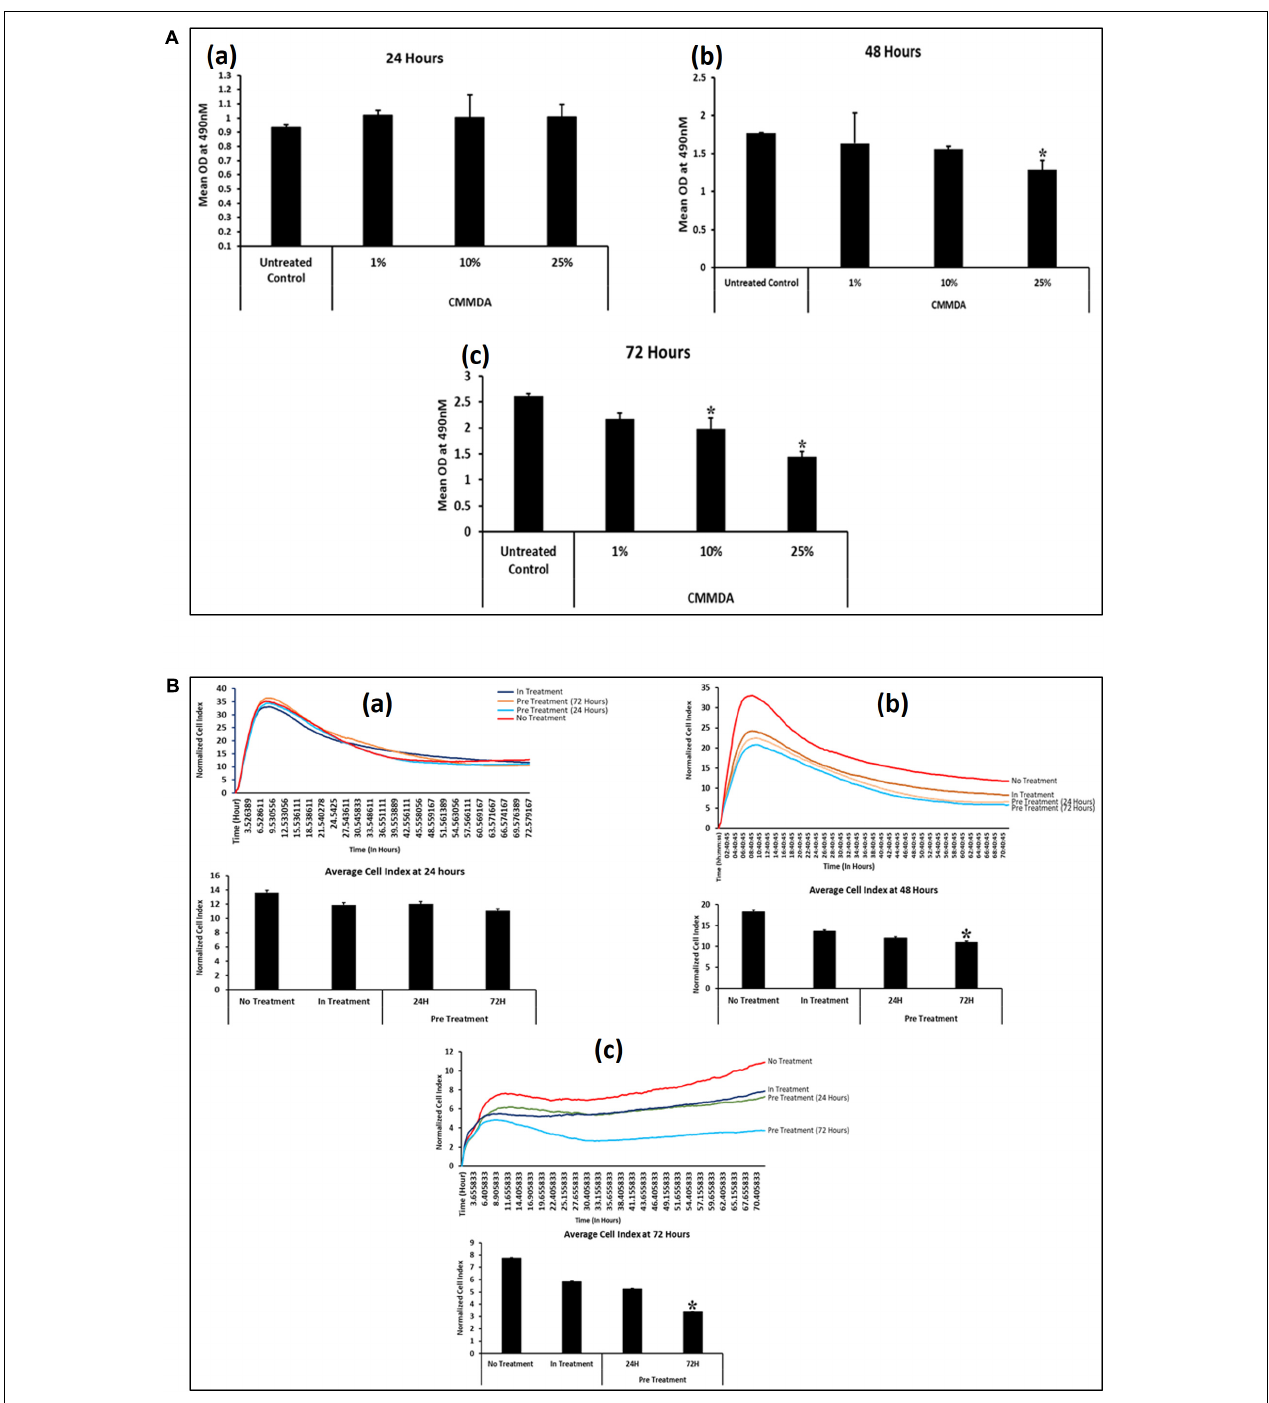
FIGURE 1 | Time and CM-MDA231 dose curve for treatment of CV-MSCs. The effect of CV-MSCs in response to various concentrations (1–25%) of CM-MDA231 at specific time points (24–72 h) using MTS (A) and xCELLigence system (B) . At 24 h, CV-MSCs proliferation did not change in response to 1–25% CM-MDA231 as compared to untreated controls (Aa) . At 48 h, CV-MSCs proliferation did not change in response to 1 and 10% concentration of CM-MDA231, but reduced significantly in response to 25% CM-MDA231 (Ab) . At 72 h and as compared to untreated controls, CV-MSCs proliferation reduced significantly in response to 10 and 25% CM-MDA231, but did not change significantly in response to 1% CM-MDA231 and untreated controls (Ac) . CV-MSCs were preconditioned with CM-MDA231 for 24 and 72 h, cultured in complete medium for 24 h post preconditioning and then their functionalities were recorded in xCELLigence system (B) . CV-MSCs did not respond to preconditioning at 24 h as compared to in-treatment and untreated control (Ba) . However, significant changes were observed at 48 and 72 h, after preconditioning the CV-MSCs for 72 h as compared to in-treatment and untreated control (Bb,Bc) . Bars represent standard errors * P < 0.05.